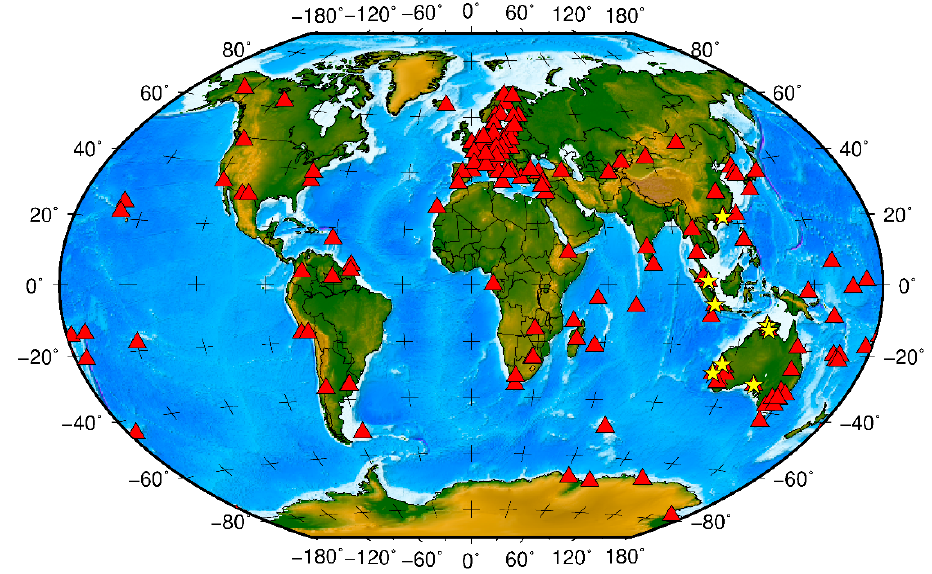
Figure 1. Geographic distribution of the reference network. Red triangles denote the 160 stations used for GPS/Galileo/BDS FCB estimation, while yellow stars denote the eight stations used to evaluate the performance of the combined systems.